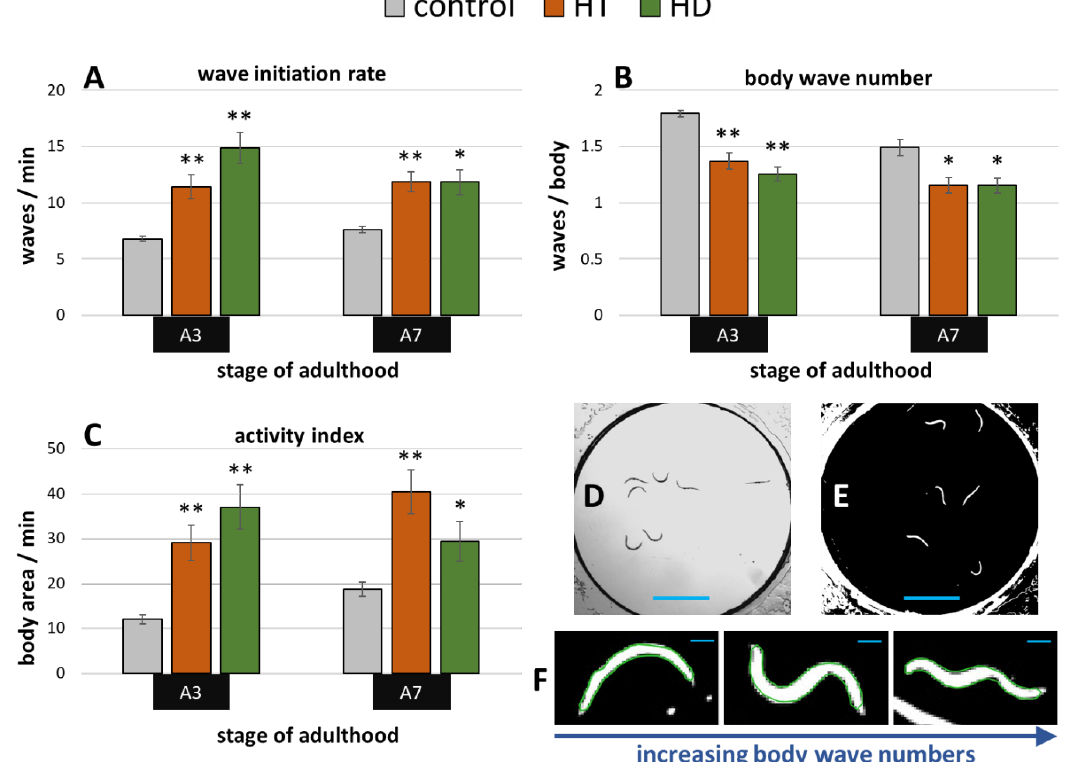
Figure 4. E ff ect of HD and HT on rotenone induced locomotion impairment. 10 µ M Figure 4. Effect of HD and HT on rotenone induced locomotion impairment. 10 µM rotenone administration with and without simultaneous HD or HT treatment started at the fourth larval stage.